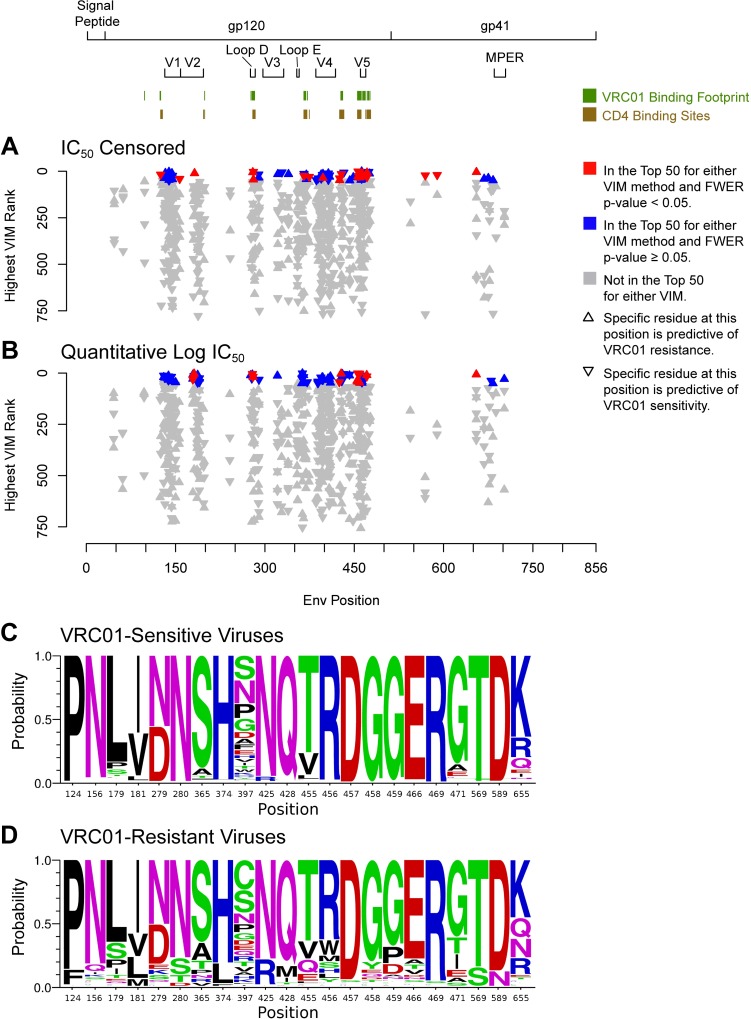
Positions, magnitudes, and distributions of amino acid residues at predictive sites selected by VIM methods.A) IC50 censored outcome; B) Quantitative log IC50 outcome. C and D) Logo plots of the probabilities of each of the amino acids observed at key positions in (C) VRC01-sensitive Env pseudoviruses and D) VRC01-resistant Env pseudoviruses. FWER, family-wise error rate; VIM, variable importance measure. The positions illustrated here correspond to the results in Tables 1 and 2 for the presence of residues at specific sites.